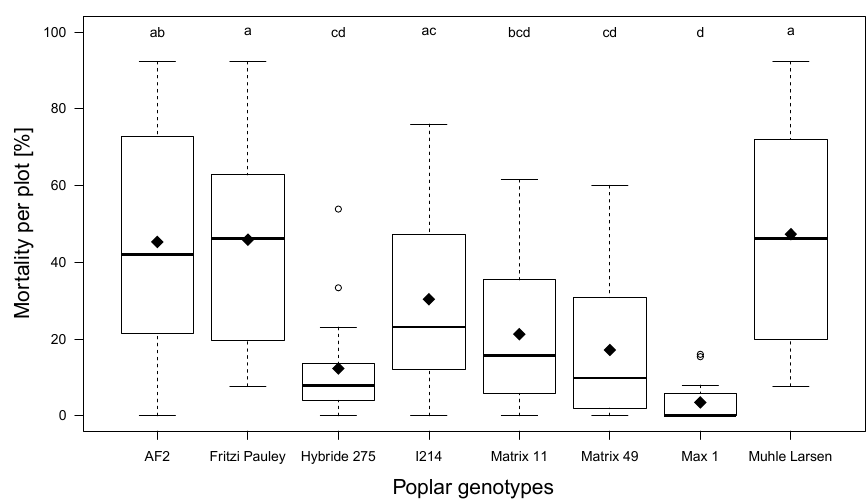
Figure 3. Mortality of all eight different poplar genotypes in pure stands, for the whole period of 3 years after planting across both study sites on the plot level. Mean values are marked by . Different letters (a, b, c, d) indicate significant differences between the genotypes at significance level p < 0.05.